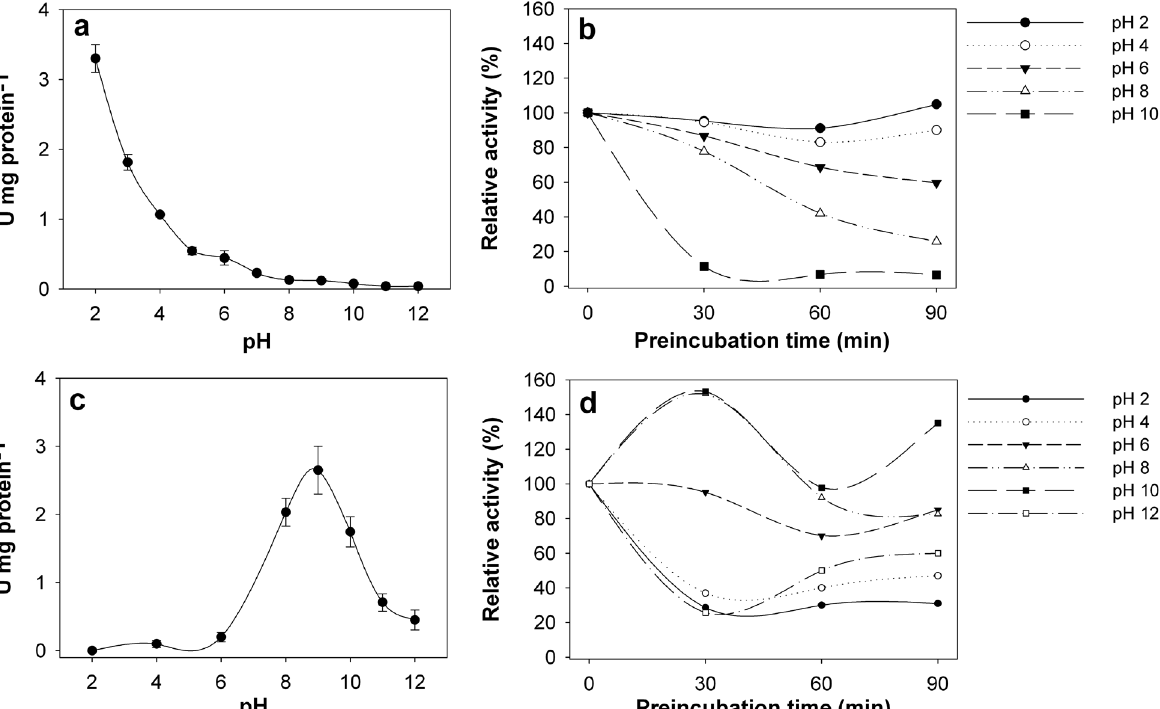
Fig. 1. pH effect on digestive proteases of juvenile sheepshead Archosargus probatocephalus: (a) optimal pH of acidic prote- ases, (b) stability of acidic proteases, (c) optimal pH of alkaline proteases, (d) stability of alkaline proteases.